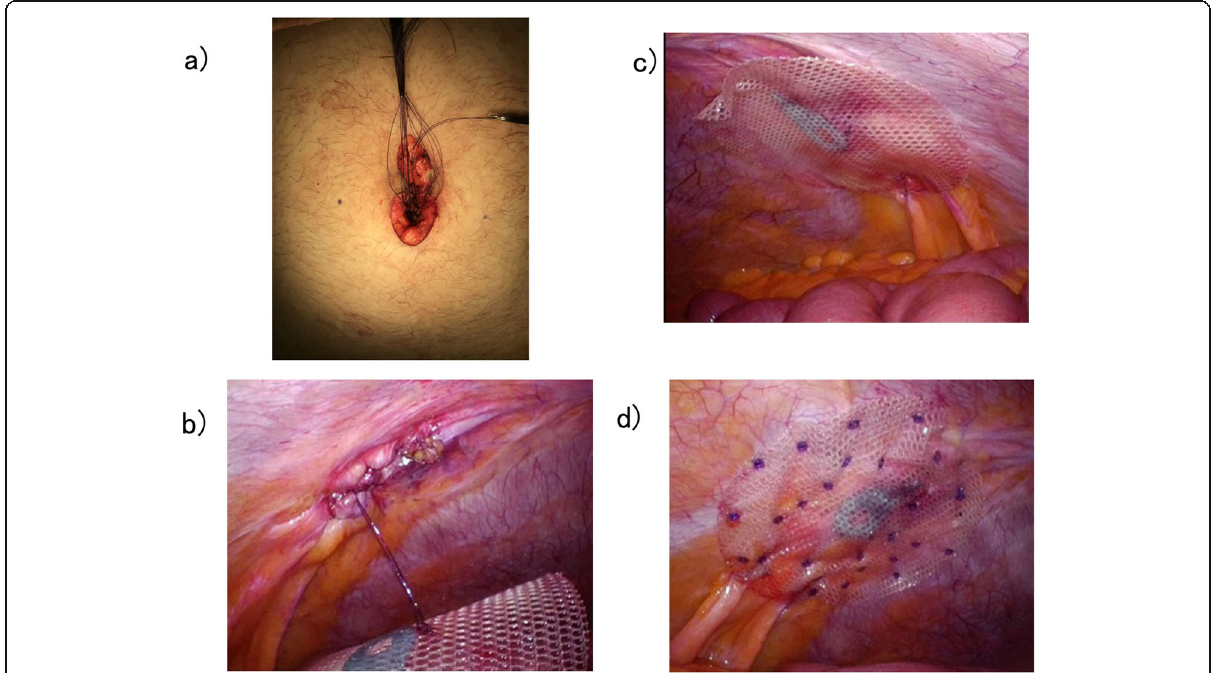
Fig. 4 Curative surgery for umbilical hernia. a Closure of the hernia orifice with simple interrupted sutures. b The hernia orifice after suture closure observed from inside the peritoneal cavity. c Temporary securing of the mesh. d Securing the mesh using the double-crown method